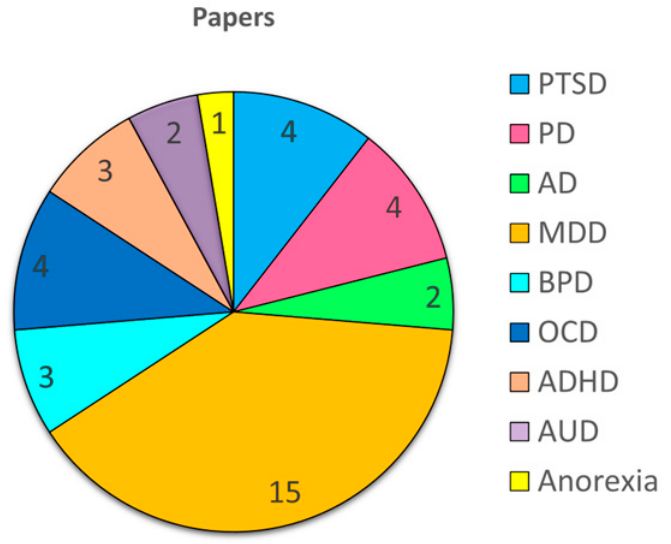
Figure 1. Distribution of reviewed papers by psychiatric disorder: a pie chart illustrating the number of articles included in this review that discuss each specific mental health condition.